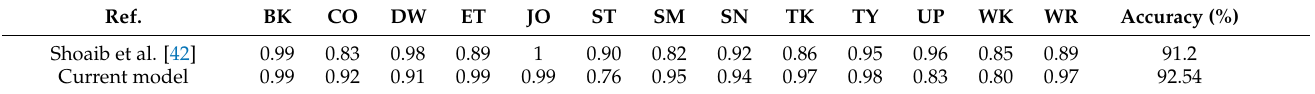
Table 6. Recognition rates of each activity for different models under 10-fold cross validation